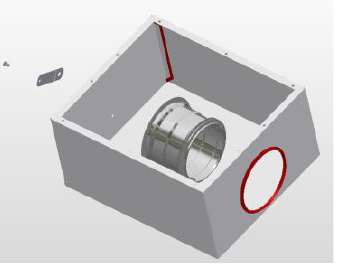
Figure 1. 3D view of a throttle valve.